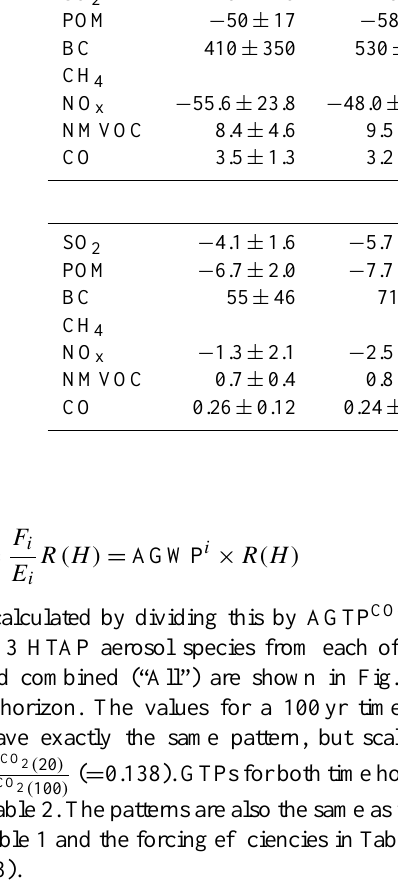
Table 2. GTPs at 20 and 100yr time horizons for the HTAP aerosols (or precursors), methane and non-methane ozone precursors. Data are given for emissions from the 4 HTAP continents separately and combined. For methane only a global number is given. Uncertainties are inter- model differences in the CTM responses to emission perturbations from Yu et al. (2013) and Fry et al. (2012). This includes uncertainties in the aerosol and ozone responses, and in the methane lifetime response. Note these values exclude the effects of aerosol cloud interactions, the effect of BC deposition on snow albedo, changes in ozone above the tropopause and carbon-cycle interactions as described in Sect. 5. EA EU NA SA All